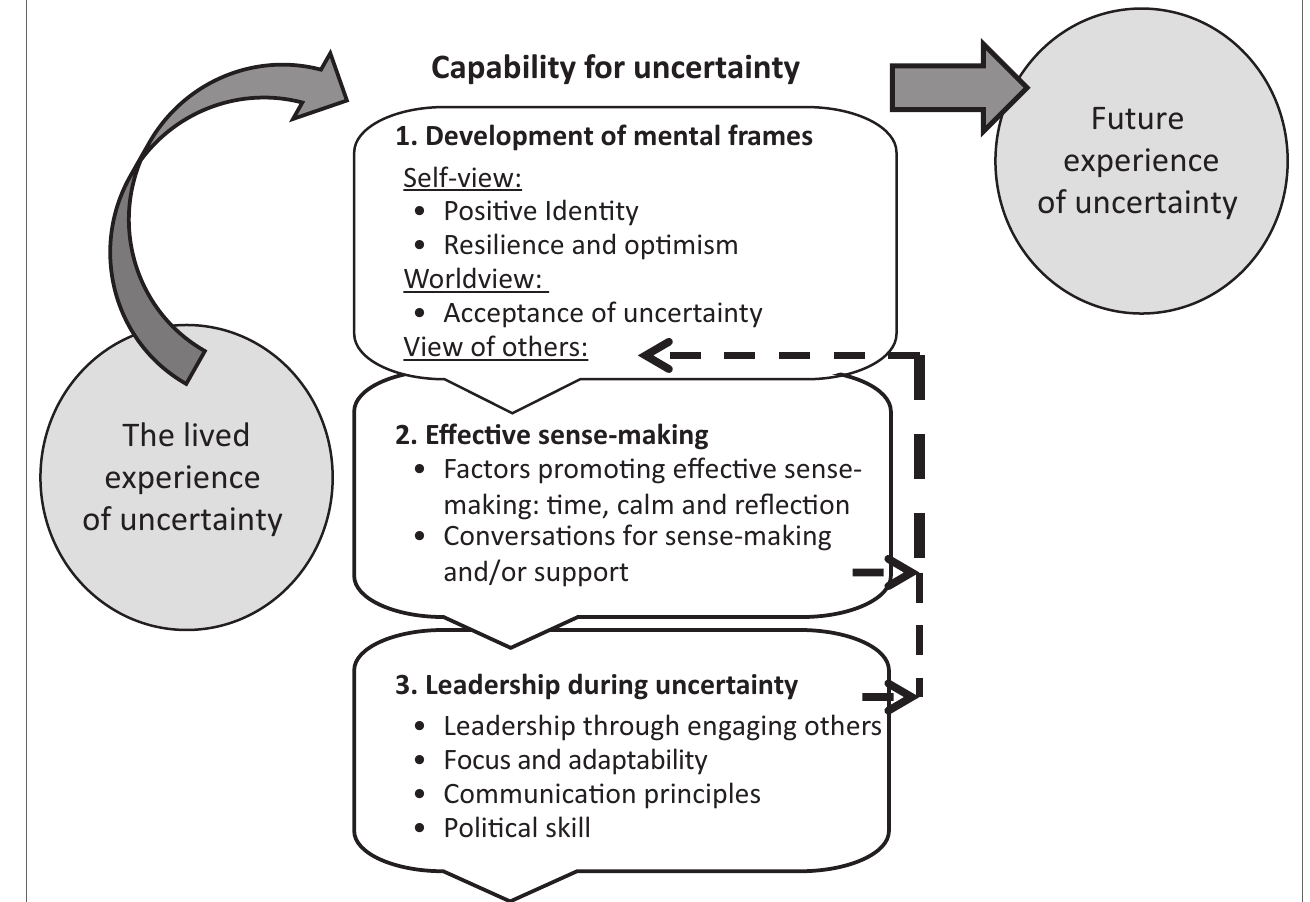
FIGURE 1: Executives’ capability for uncertainty developed through lived